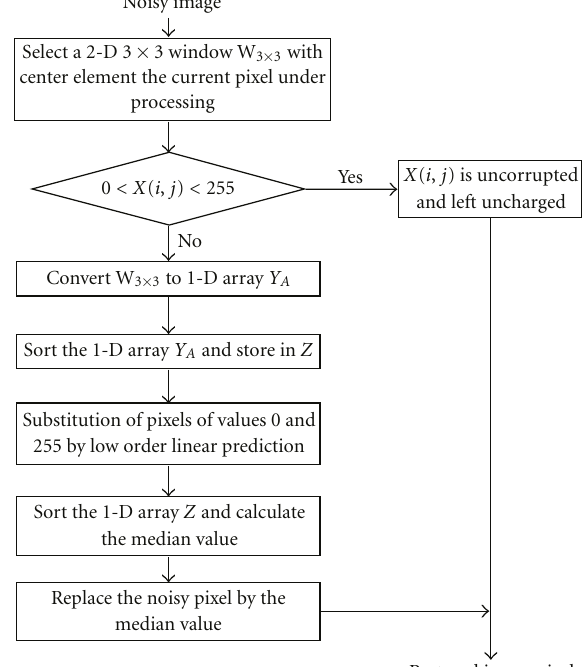
Figure 1: Flowchart of the proposed scheme.